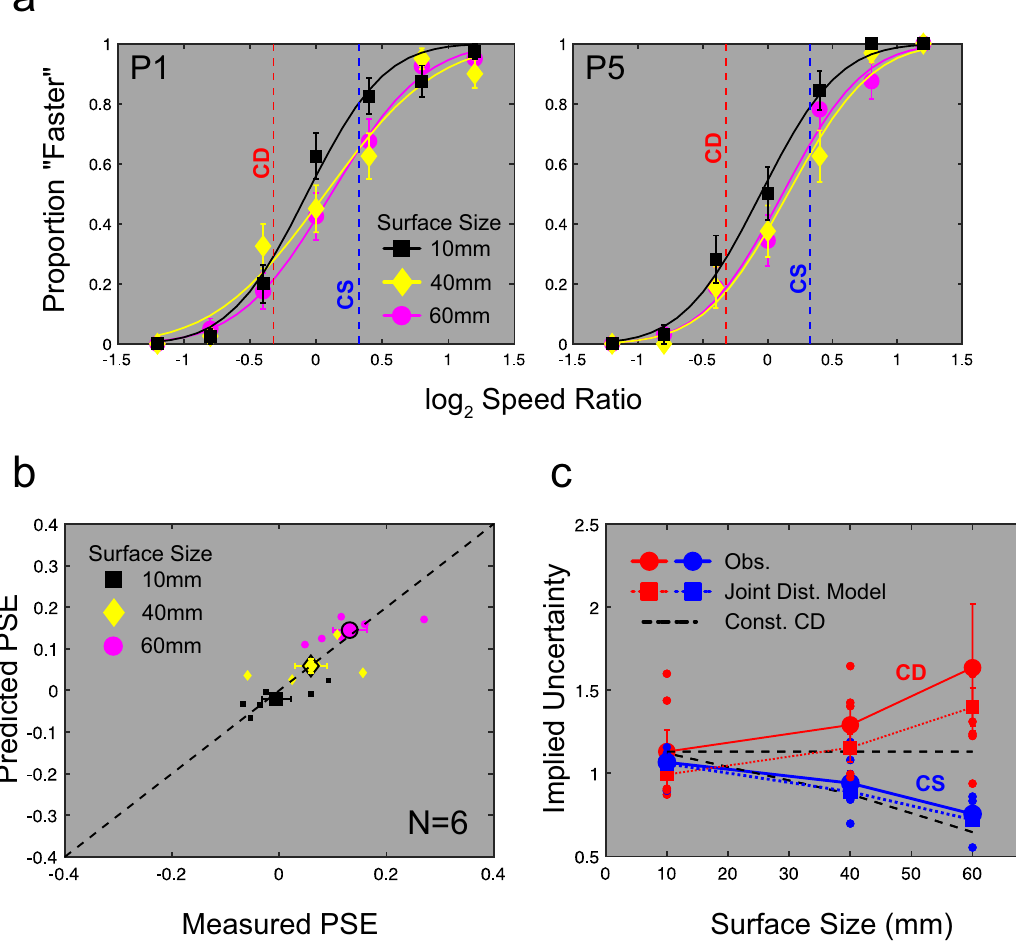
Figure 2. Human speed-in-depth discrimination is accounted for by the joint distribution model. ( a ) Psychometric functions for 2 example observers show shifts in PSE towards the CS cue with increasing surface size. ( b ) Shifts are well-predicted by our joint distribution model, across all participants (smaller symbols show individual participants, larger symbols show mean performance). ( c ) Implied cue uncertainties as a function of object size for CD (red) and CS (blue) cues. Continuous lines with large circles show implied uncertainties averaged across observers. Error bars show the standard error on the mean. Small circles show individual implied uncertainties. Coloured dotted lines with large squares show the implied uncertainties predicted by the joint distribution model. Black dashed lines show the expected change in implied CS uncertainty when CD uncertainty is held constant (see “Methods” for details). Our model predicted observed changes in implied cue uncertainty that would otherwise require ad hoc changes to standard cue integration